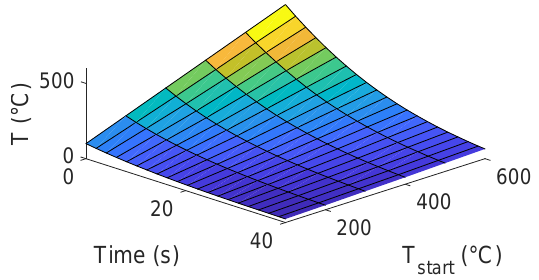
Figure A7. Specimen cooling at various starting